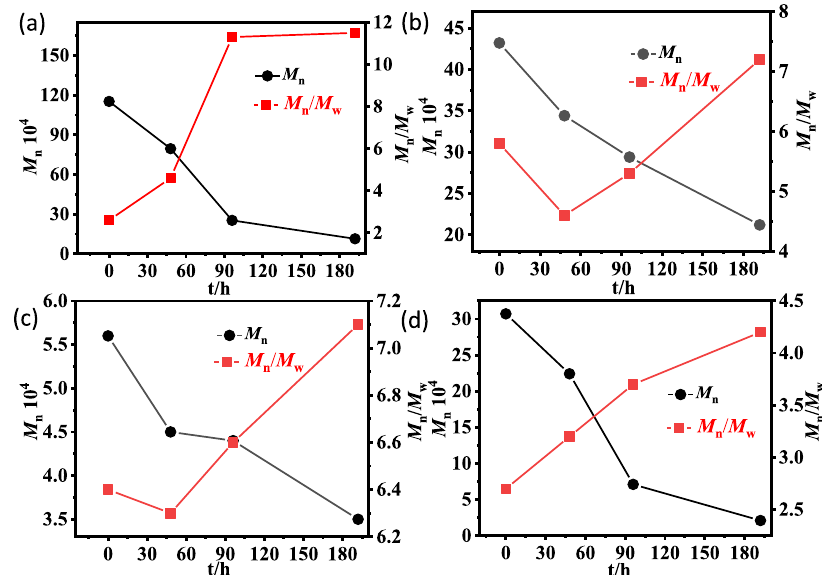
Fig. 6 Photocatalytic degradation of polyethylene-TiO 2 composites. a The in situ generated sample obtained using Ni-ONa-TiO 2 . b The sample obtained by blending 95% high-molecular-weight polyethylene with 5 wt% TiO 2 . c The sample obtained by blending 95% commercial polyethylene with 5 wt% TiO 2 . d Sample prepared from the copolymerization of ethylene and methyl 10-undecylenate using Ni-ONa-TiO 2 ; polar monomer incorporation of